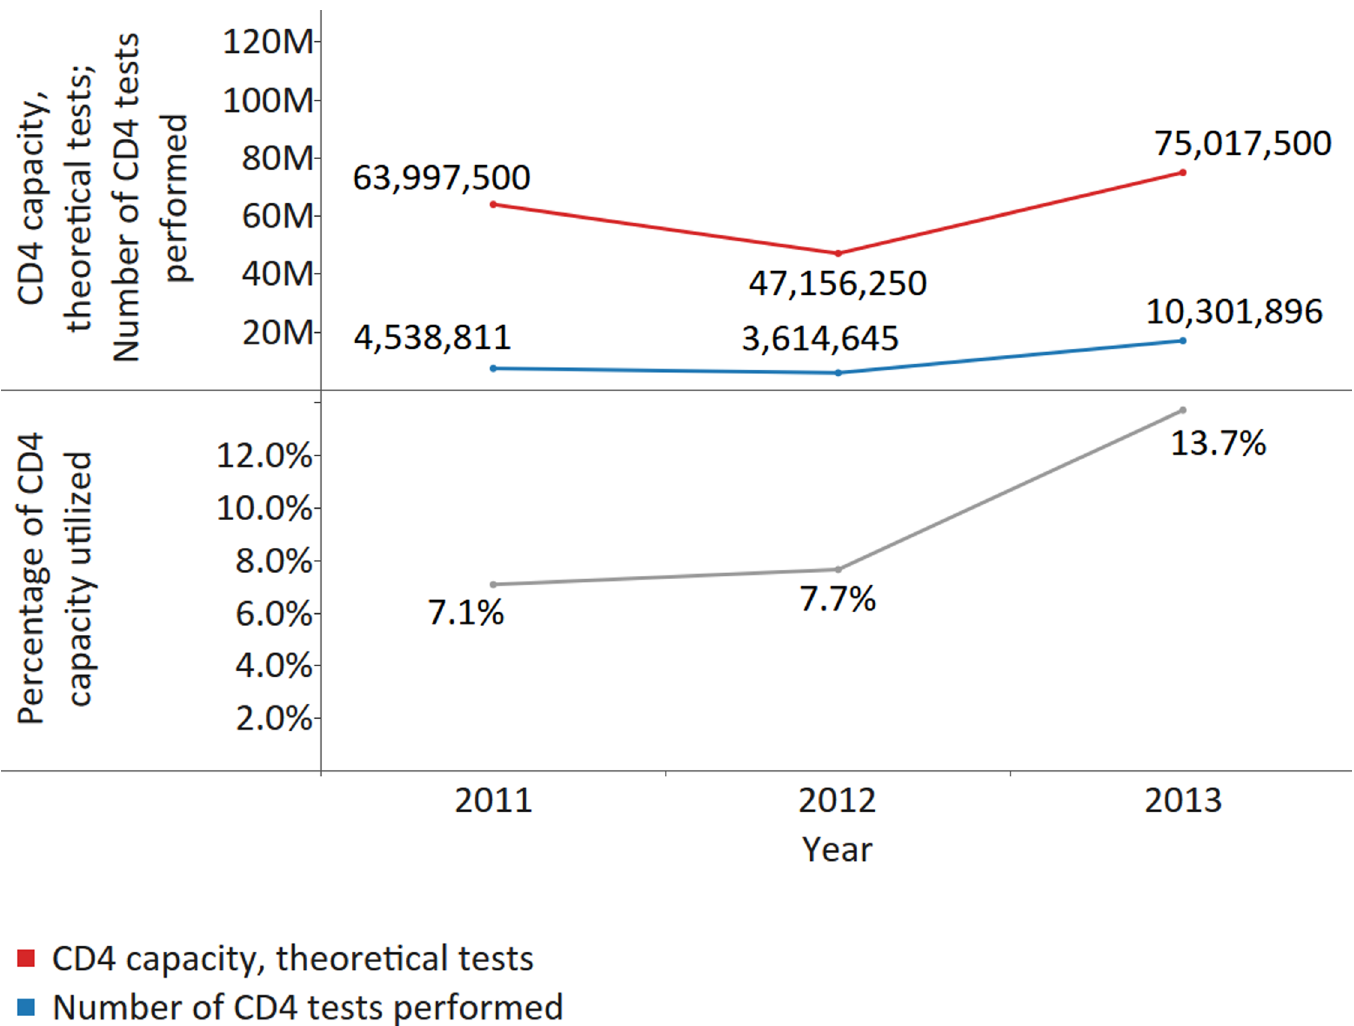
Fig 4. Utilization of CD4 capacity, for all reporting countries. The upper panel displays the number of CD4 tests performed and the theoretical CD4 capacity for countries reporting data on the number of tests performed and the number of CD4 instruments (51, 45, and 50 countries reporting for 2011, 2012, and 2013). The lower panel displays the percentage of CD4 capacity utilized during the reporting